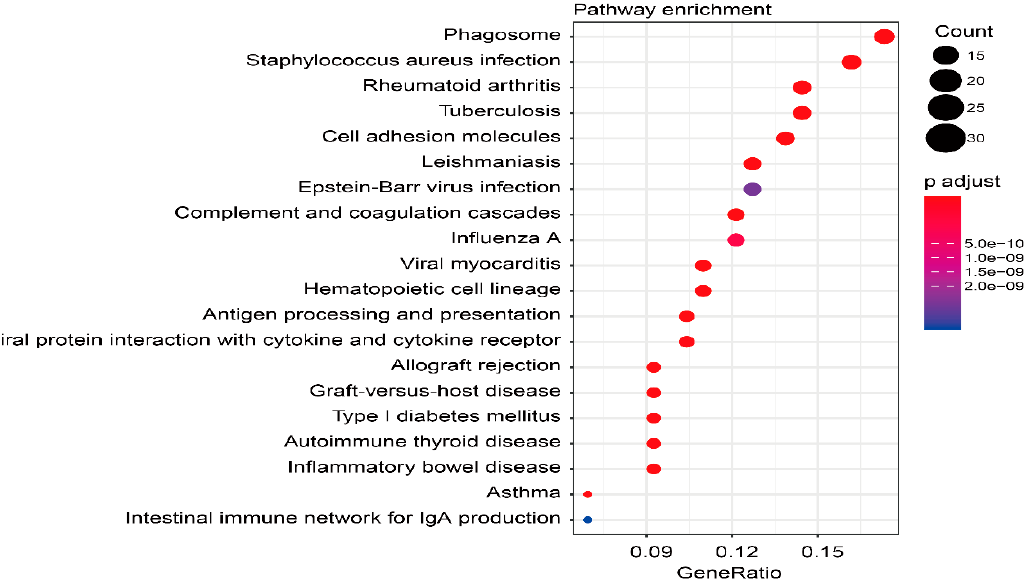
Figure 16. KEGG pathway analysis of 271 TME-related subtype genes, with the 10 most significant pathways.